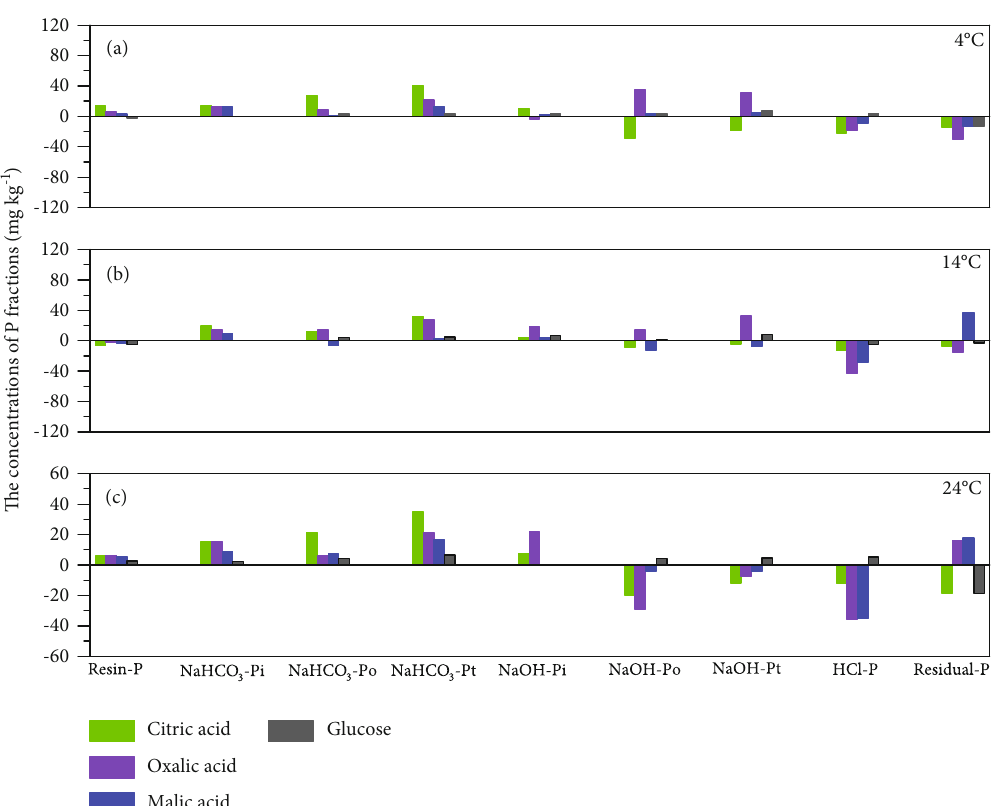
Figure 1: The variations of P fraction after addition of low molecular weight organic acids (oxalic acid, citric acid, and malic acid) and glucose compared with deionized water at di ff erent temperatures ((a) 4 ° C; (b) 14 ° C; (c) 24 ° C).